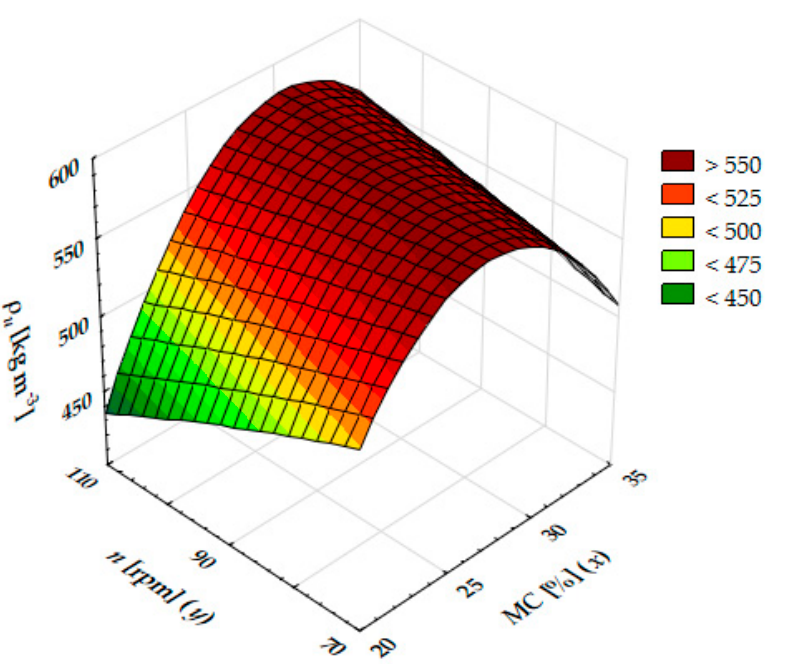
Figure 6. Influence of the rotational speed of the extruder screw and the level of raw material moisture on the bulk density of the extrudate.